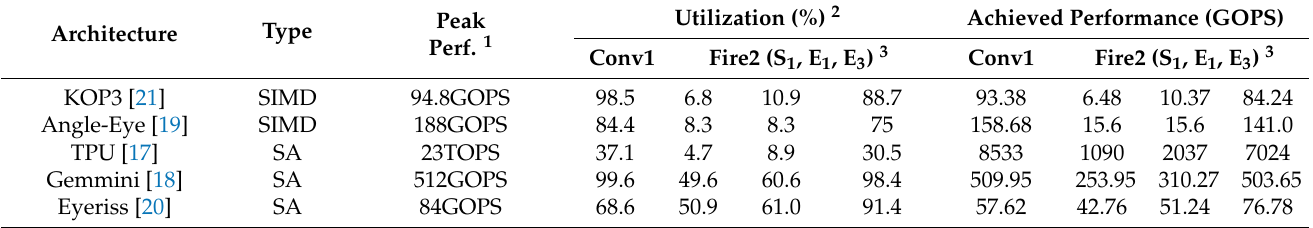
Table 2. Acceleration utilization of SqueezeNet v1.1 on NPUs.